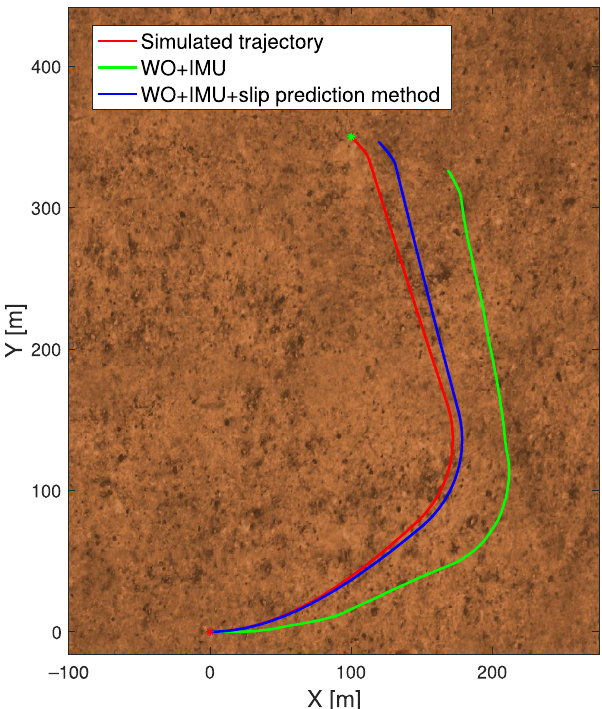
Figure 13. Reconstructed trajectory using WO and IMU and reconstructed trajectory using WO, IMU and slip prediction method jointly, vs. simulated trajectory.